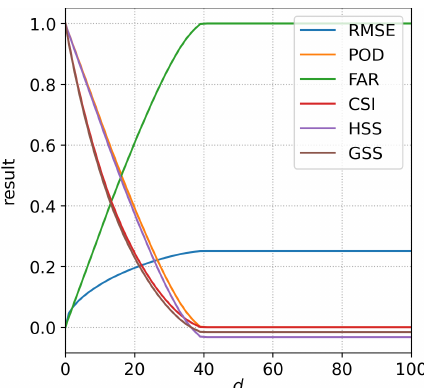
Figure 5. Same as the bottom frame of Figure 1a but instead of the distance metrics, the results of six non-spatial measures are shown: root-mean-square-error (RMSE), probability of detection (POD, also called hit rate), false alarm ratio (FAR), critical success index (CSI, also called threat score), Heidke skill score (HSS) and Gilbert skill score (GSS, also called equitable threat